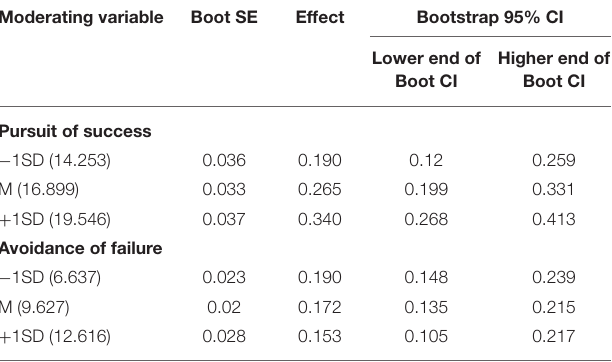
TABLE 7 | Bootstrap testing for the moderated mediation effect. Moderating